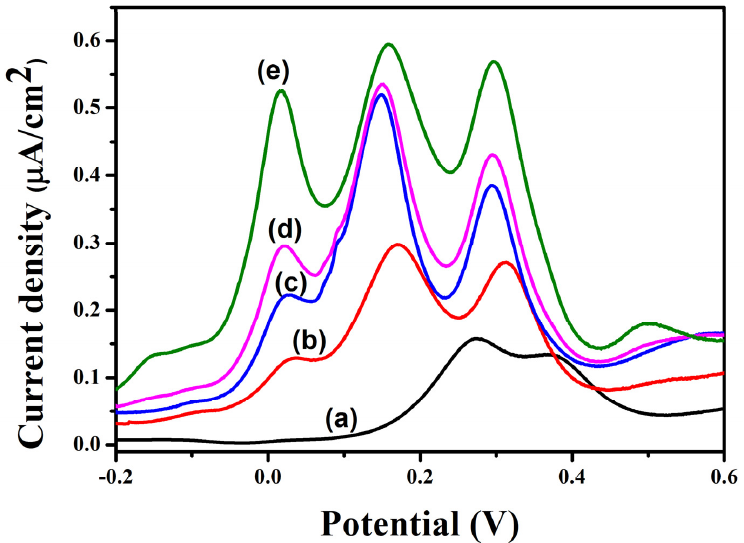
Figure 8. Differential pulse voltammograms obtained with ( a ) CPE, ( b ) EPI, ( c ) EPIS, ( d ), EPIP, and ( e ) EPIG modified electrodes for a tertiary mixture of 10 uM AA/DA/ UA in 0.1 M PBS.